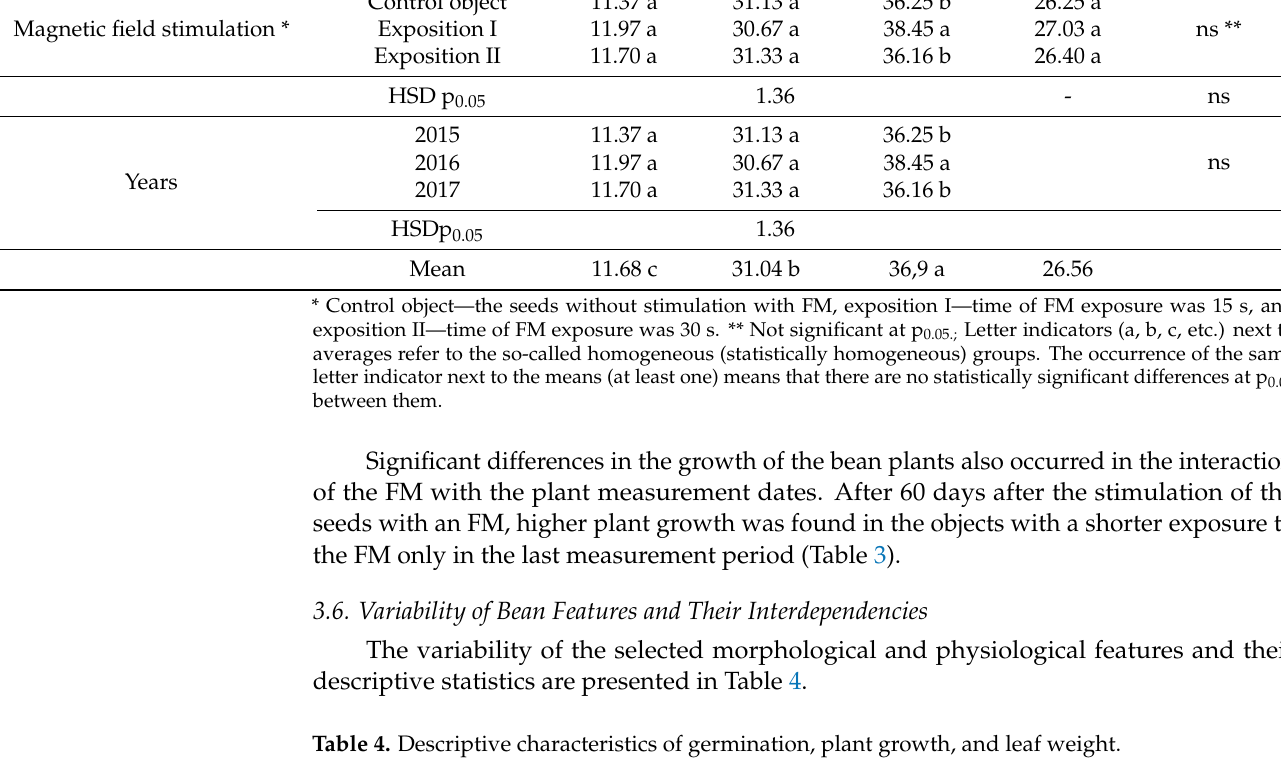
Table 4. Descriptive characteristics of germination, plant growth, and leaf